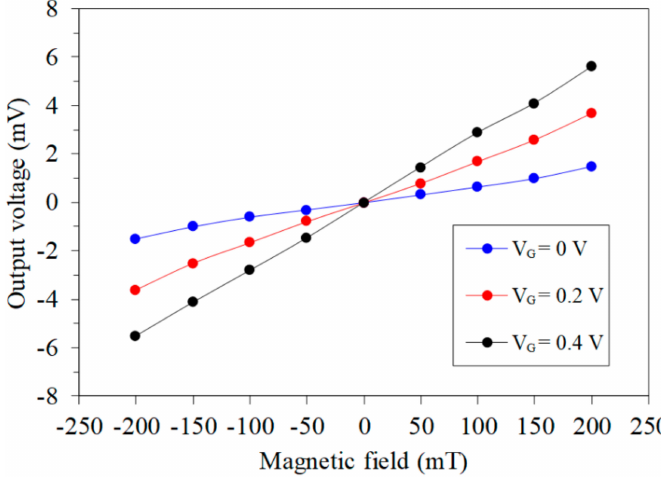
Figure 10. Tested OV in the z -axis magnetic